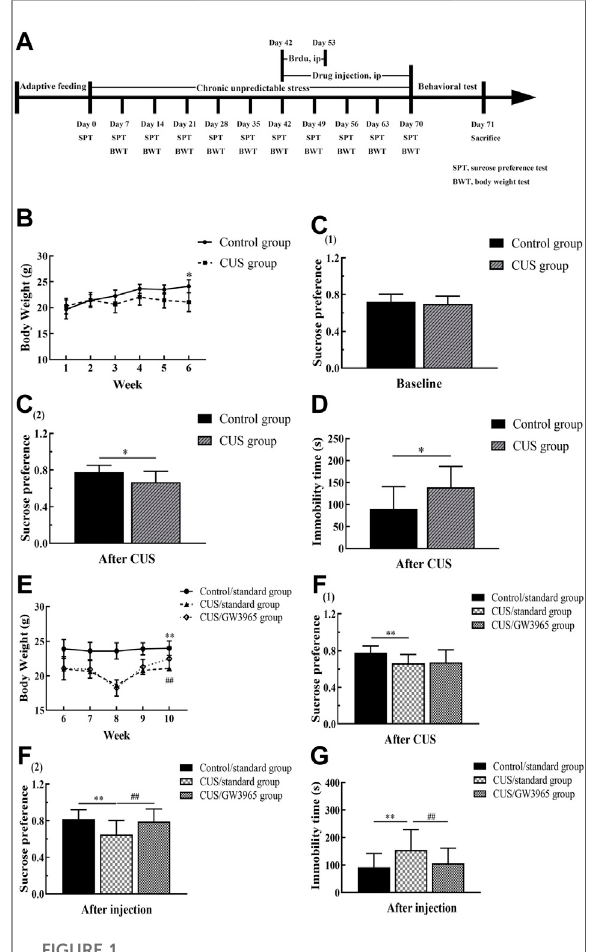
FIGURE 1FIGURE 1 group. ## indicates p < 0.05 for the CUS/standard group com- pared with the CUS/GW3965 group. All the data are shown as the means ±